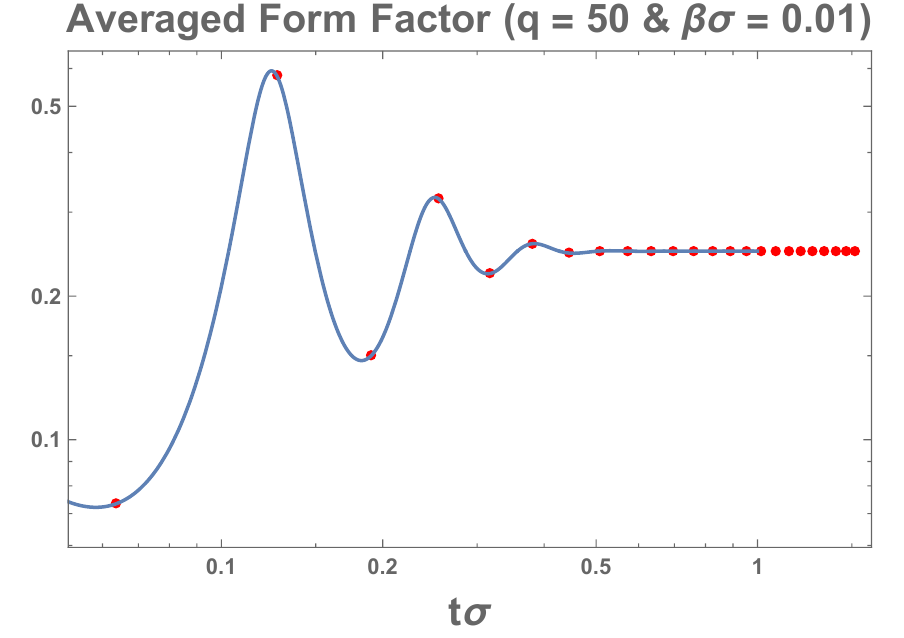
Figure 20 . We plot the expression of the form factor in eq. (3.17) for q = 50 , βσ = 0 . 01 . The red dots indicate points on the form factor at t n σ = 1 . 01 πn/ 50 . We can see that the points roughly occur local maxima and minima of the form